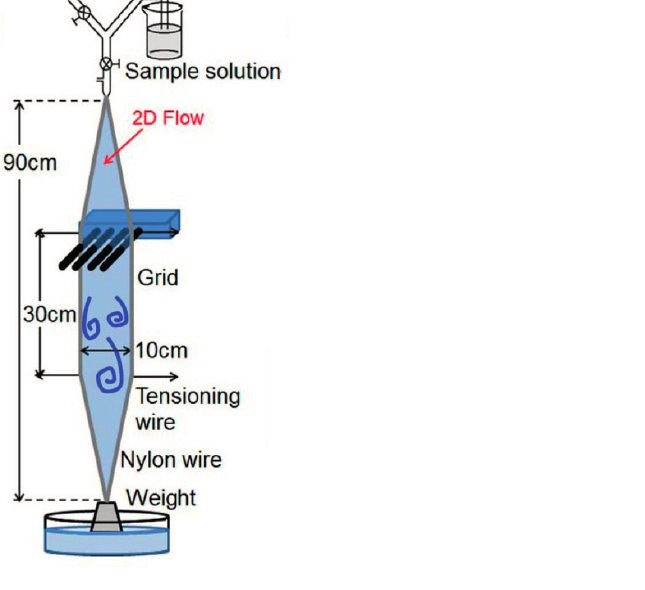
Figure 2. Schematic diagram of experimental set-up of flowing soap films (Reprinted from